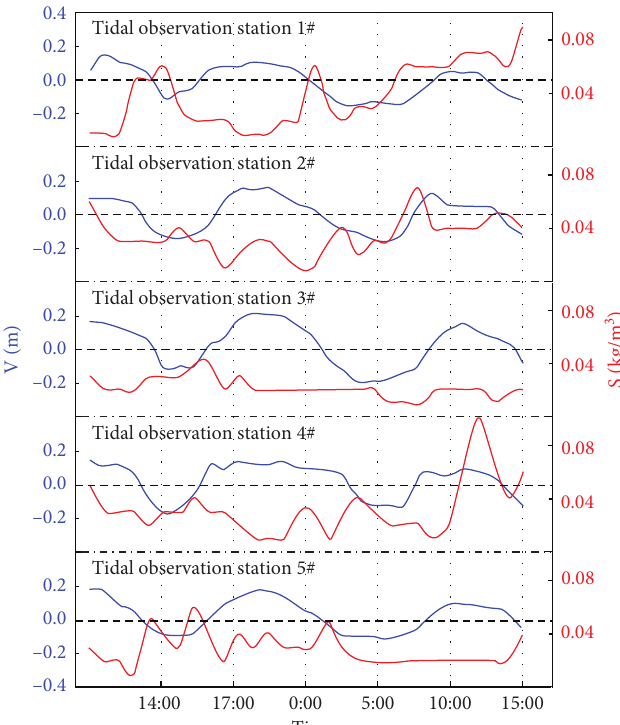
Figure 4: The vertical resultant velocity and sediment concentration of the spring tide during Sep. 22 ∼ 23, 2015. The blue curves are the vertical resultant velocities at each tidal observation station corresponding to the left blue axis. The red curves are the sediment con- centration measured at each tidal observation station corresponding to the right red axis.